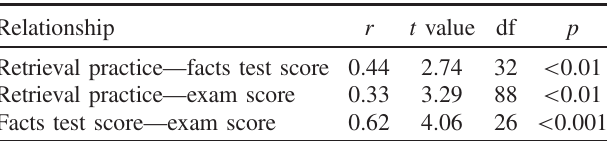
TABLE I. Correlations between retrieval practice sessions attended, the declarative facts test, and final exam score. Relationship